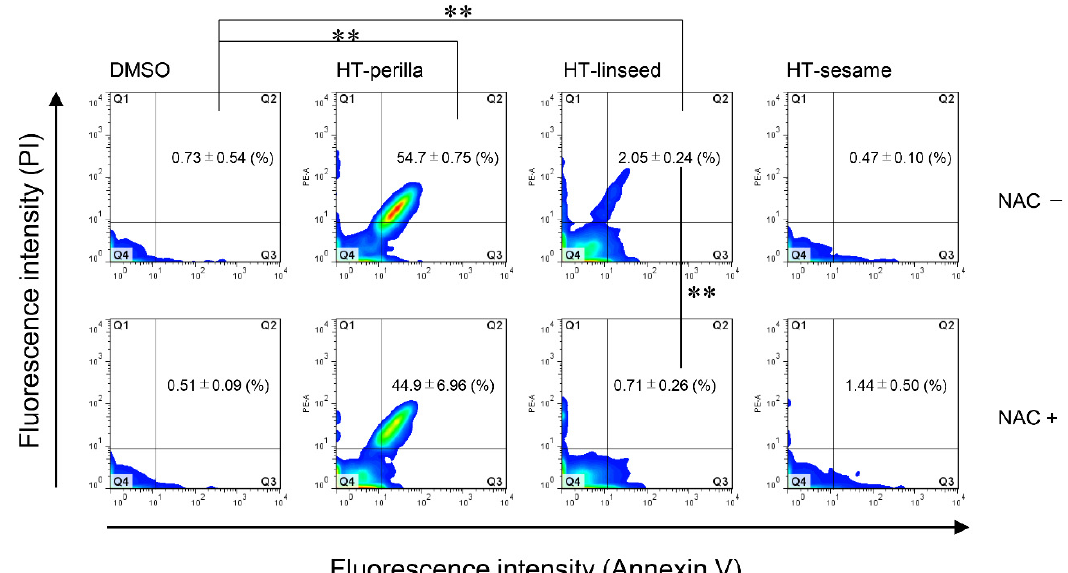
Figure 4. Heat-treated oils induced apoptosis in SH-SY5Y cells. SH-SY5Y cells were pretreated with or without NAC (10 mM, 12 h), and then exposed to heat-treated oils (3 d, 1 mg / mL) for 24 h. After exposure to heat-treated oils, cells were stained with Annexin V-FITC and PI, and then analyzed by flow cytometry. One-way ANOVA with Tukey–Kramer’s test was used. ** p < 0.01 compared with DMSO treatment. Values represent mean ± SD (n = 3).